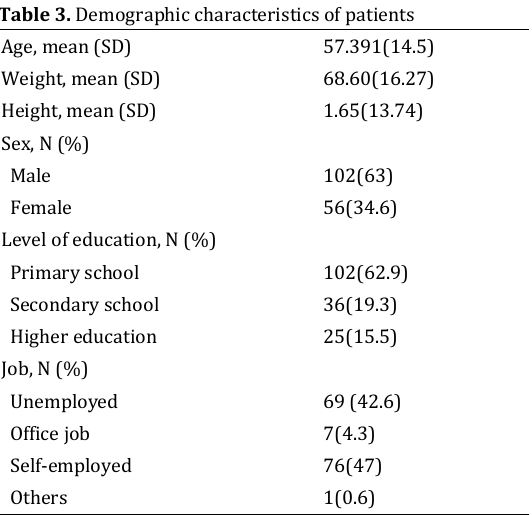
Table 3. Demographic characteristics of